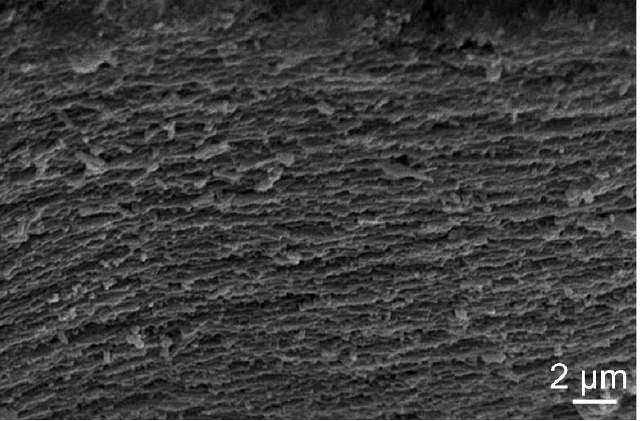
Figure 13. Fibrous structure in Torellella sulcata from the upper Cambrian of Estonia.